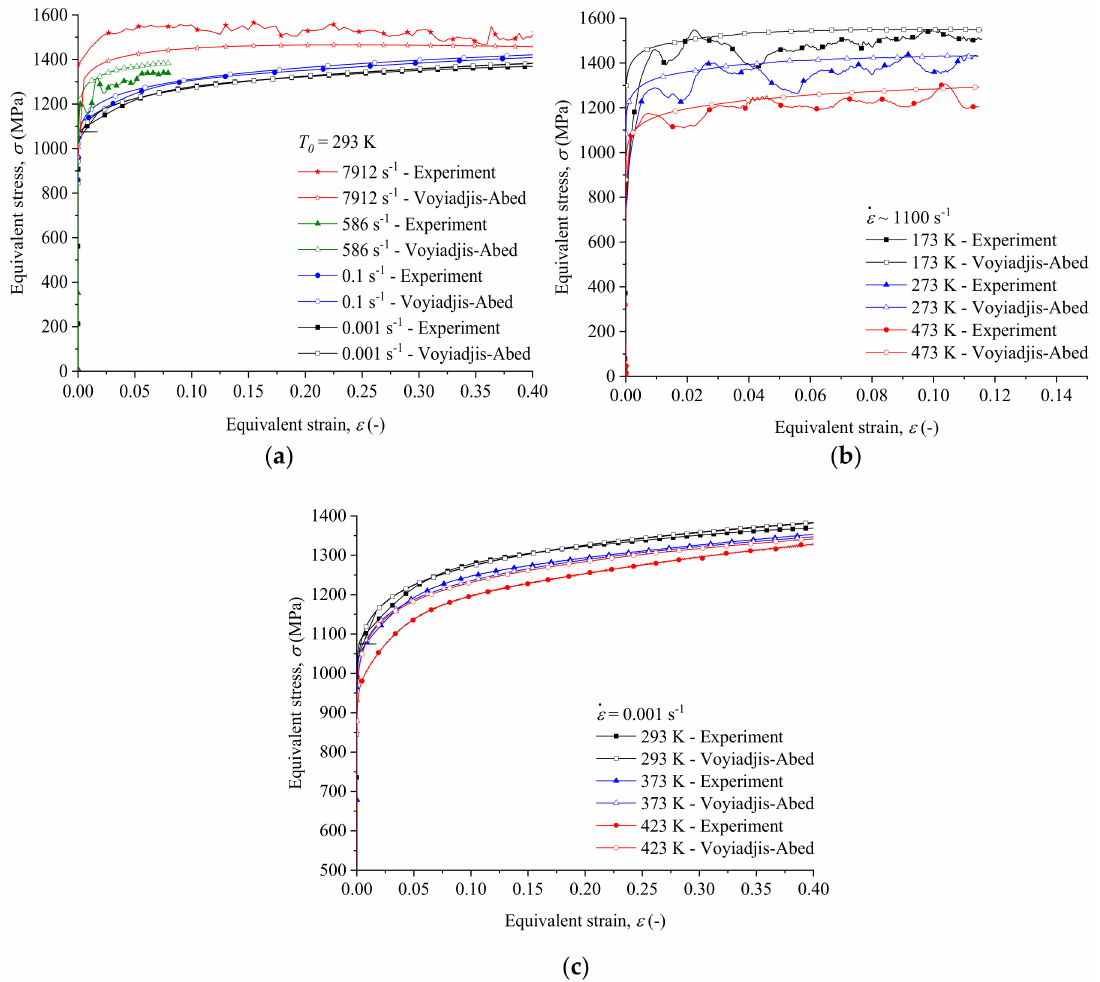
Figure 13. Comparison of the original Voyiadjis–Abed model and the experimental data: ( a ) for different strain rates, at T 0 =293 K; ( b ) for different temperatures, at ˙ ε ~1100 s − 1 ; and ( c ) for different temperatures, at ˙ ε = 0.001 s − 1 .